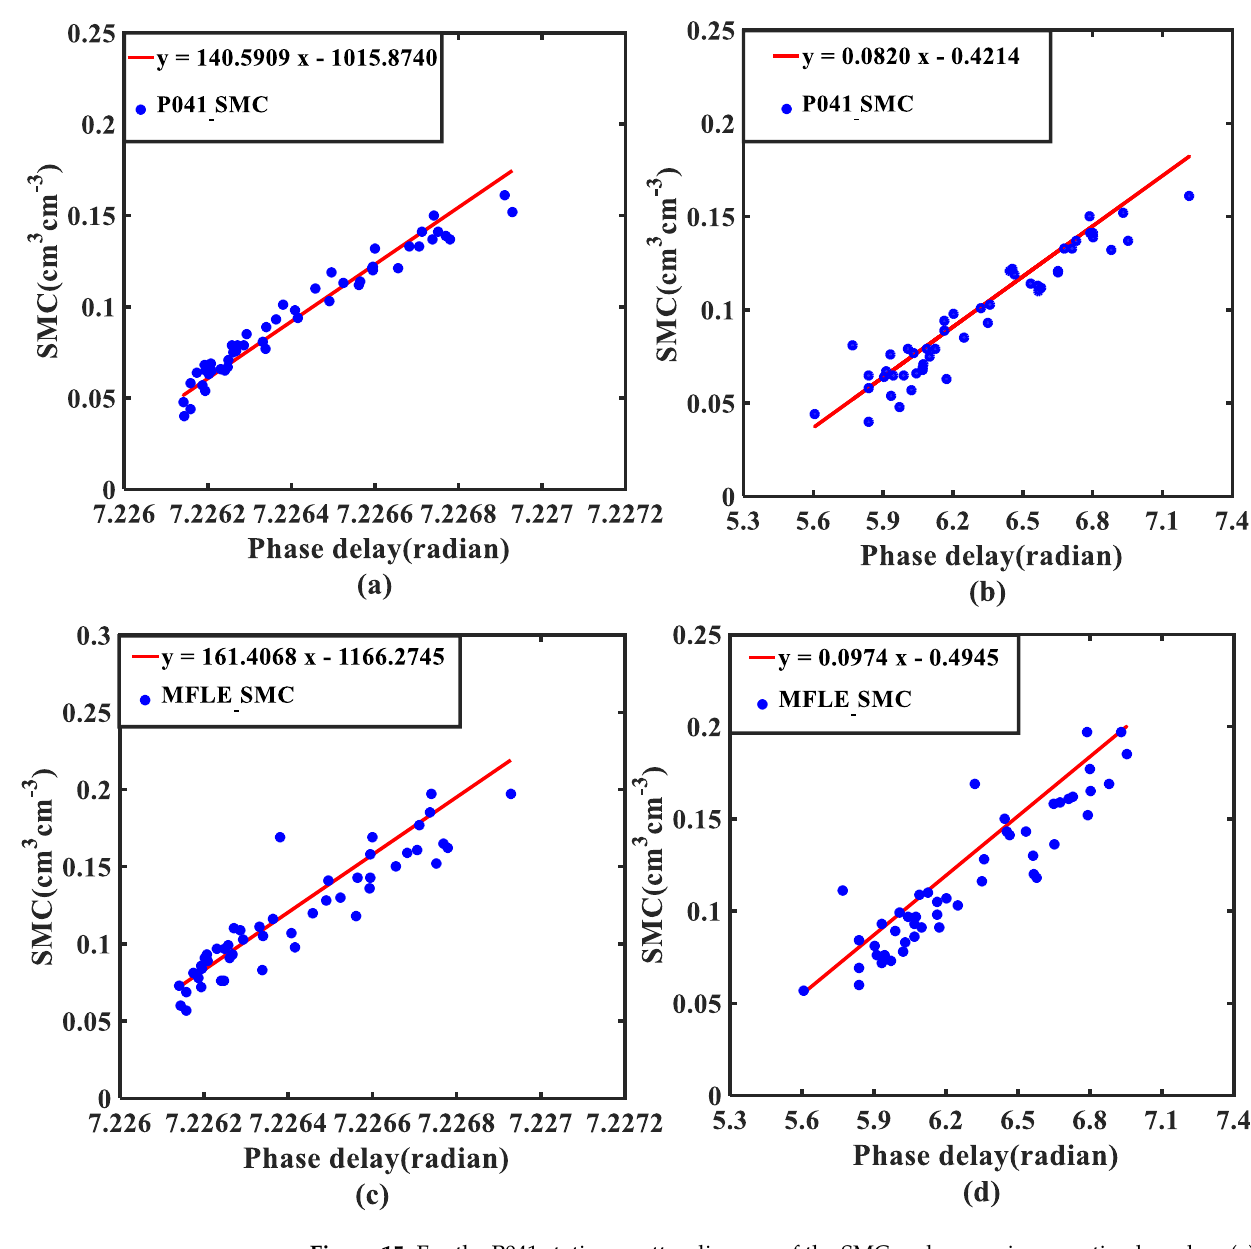
Figure 15. For the P041 station; scatter diagram of the SMC and regression equation based on ( a ) the L4_IF method; ( b ) the DFP multipath model. For the MFLE station; scatter diagram of the SMC and regression equation based on ( c ) the L4_IF method; ( d ) the DFP multipath model. Table 3. Statistical table for accuracy comparison between L4_IF and DFP and the statistical results are shown in Table 3.